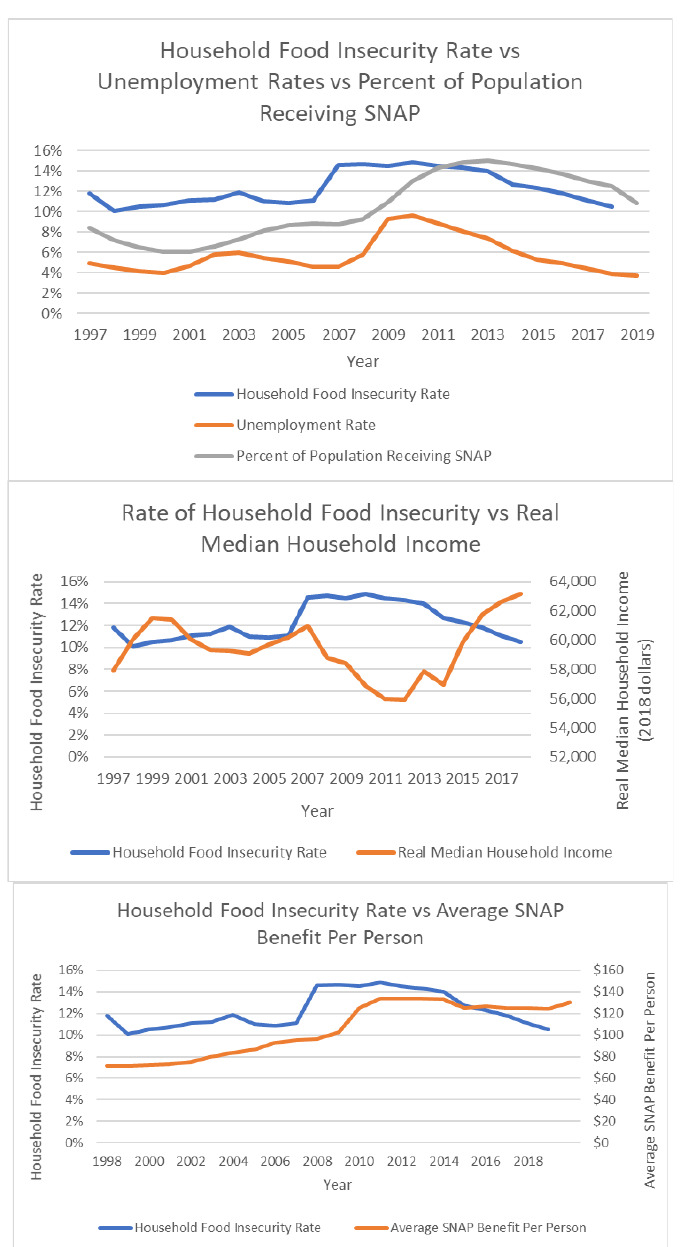
Figure 8. Rate of food household insecurity [3] compared to unemployment rates [38], mean